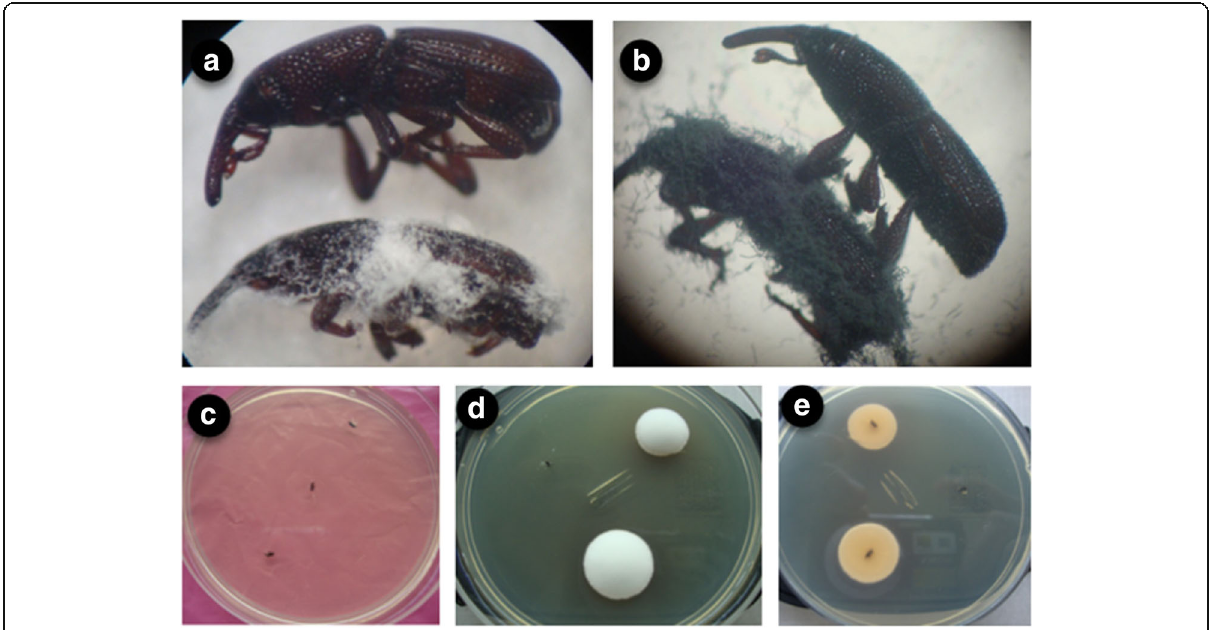
Fig. 1 Infection and isolation of two species of EPF from adults of Sitophilus granarius (strain SG5), a Infection of S. granarius adult (lower picture) with Beauveria bassiana (strain BB2) exhibited by white superficial mycelium growth, upper picture is uninfected or healthy. b Infection of S. granarius ’ adults (lower picture) with Metarhizium anisopliae (strain MA1) exhibited by olive green superficial mycelium growth, upper picture is uninfected or healthy. c Isolation technique of ingested conidia of B. bassiana or M. anisopliae from treated adults of S. granarius after being superficially disinfected then plated using a selective medium (SDA + Chloramphenicol). d – e Growth of B. bassiana on the plate surface with a selective medium (SDA + Chloramphenicol) (upper and lower views of fungus growth as a white dense mycelia growth on the plate ’ s surface in case of positive